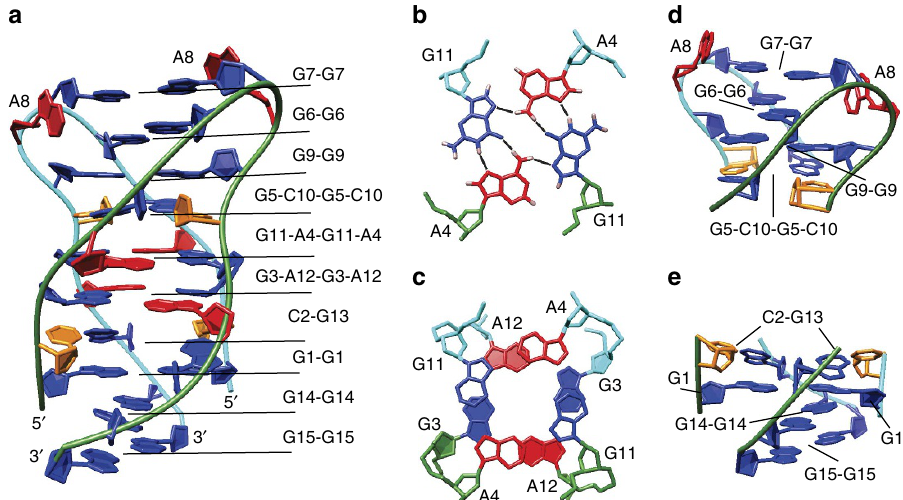
Figure 3 | Structure of VK34 dimer. ( a ) Representation of the lowest-energy overall structure. ( b ) Top view of the G11-A4-G11-A4 quartet with marked hydrogen bonds. ( c ) Top view of stacked G3-A12-G3-A12 and G11-A4-G11-A4 quartets with a helical twist of 25 (cid:2) depicted with filled and unfilled residues, respectively. ( d ) Side view of the G5-C10-G5-C10 quartet and G6-G6, G7-G7 and G9-G9 base pairs. ( e ) Side view of two buckled C2-G13 base pairs and G1-G1, G14-G14 and G15-G15 base pairs. The guanine residues are coloured blue, adenine red and cytosine orange. The two strands are coloured green and